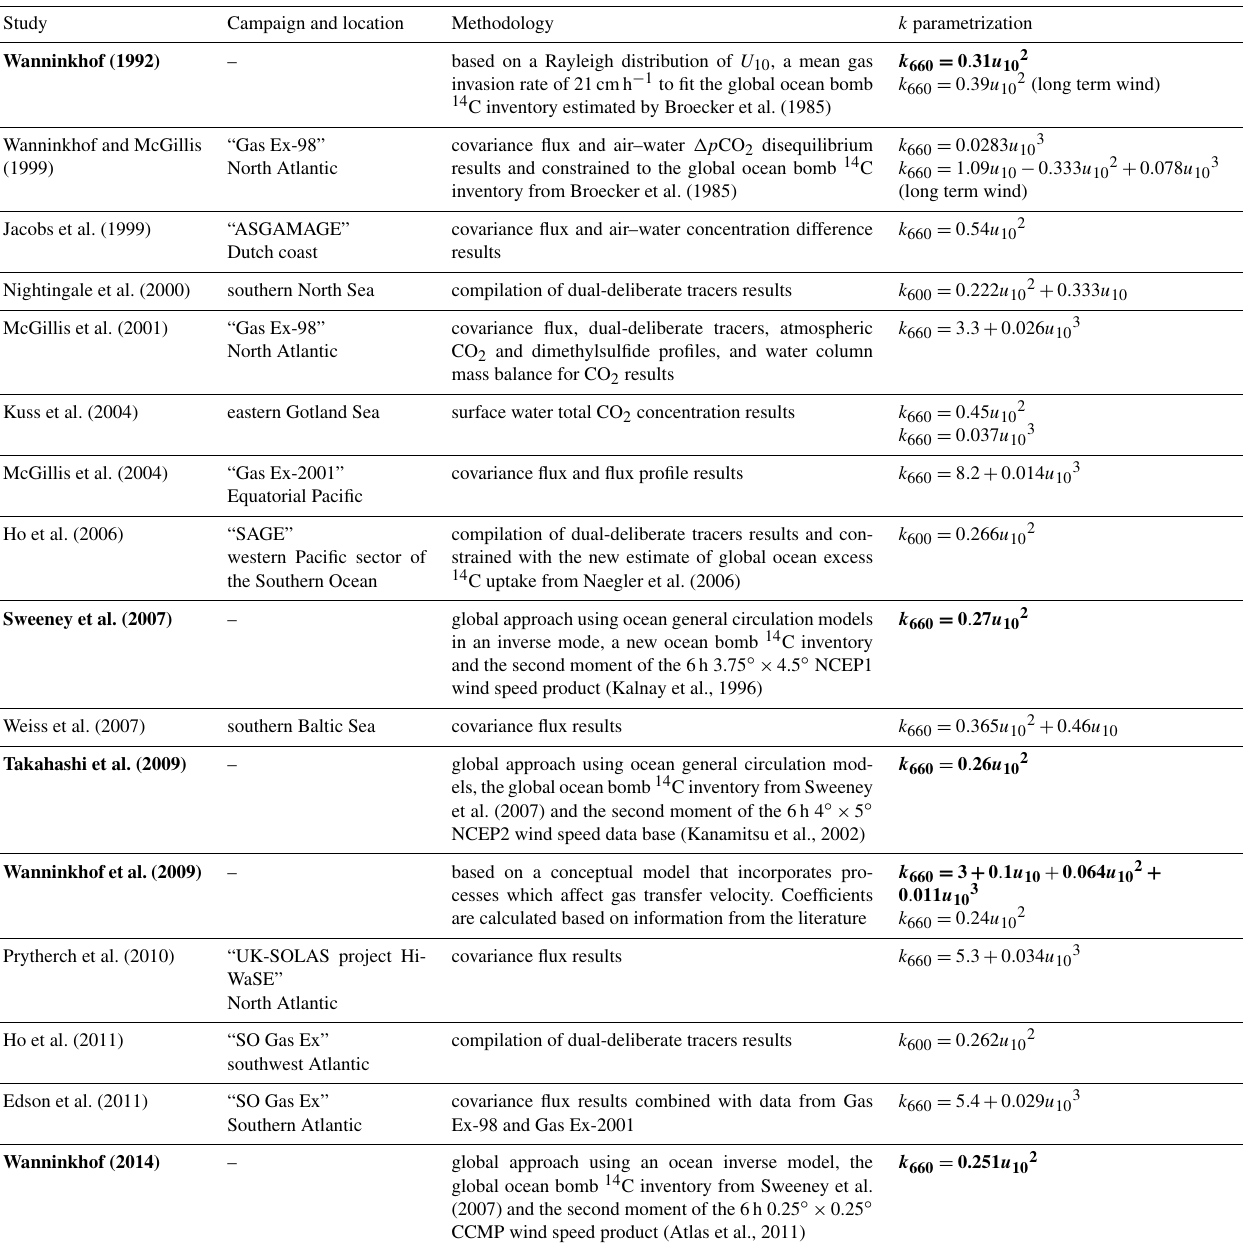
Table 2. Historical summary of k relationships using U 10 in the ocean. Depending on the study, k is either expressed as k 660 or k 600 , which represent the gas exchange transfer velocity of CO 2 at 20 ◦ C in seawater (SSS = 35) and freshwater (SSS = 0), respectively. Also note that some equations are developed for the use of monthly mean wind speeds (denoted “long term”) while others are developed for instantaneous daily/weekly wind speed (see Wanninkhof, 1992, for details). The equations used in our analysis are identified in